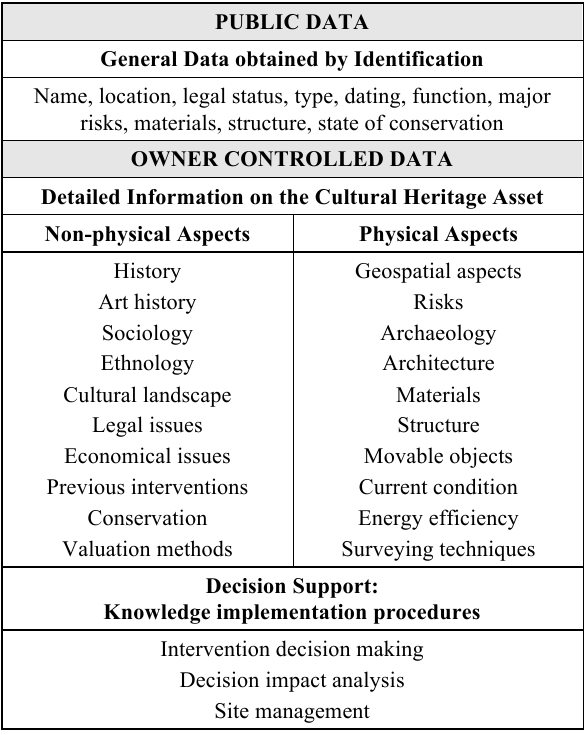
Table 1. The content of the Cultural Heritage Identity